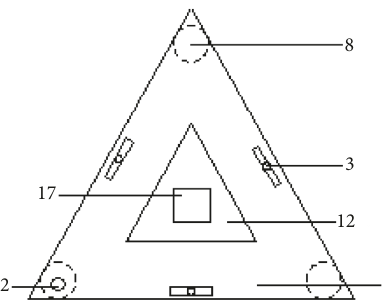
Figure 17: Top view structure diagram.